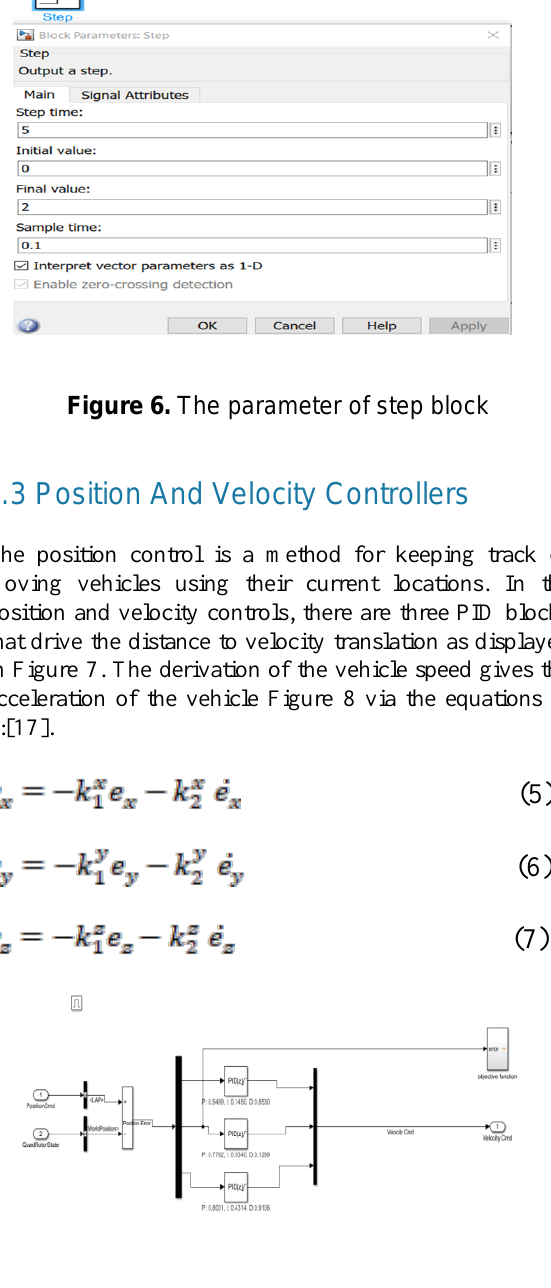
Figure 5. Control system design strategy